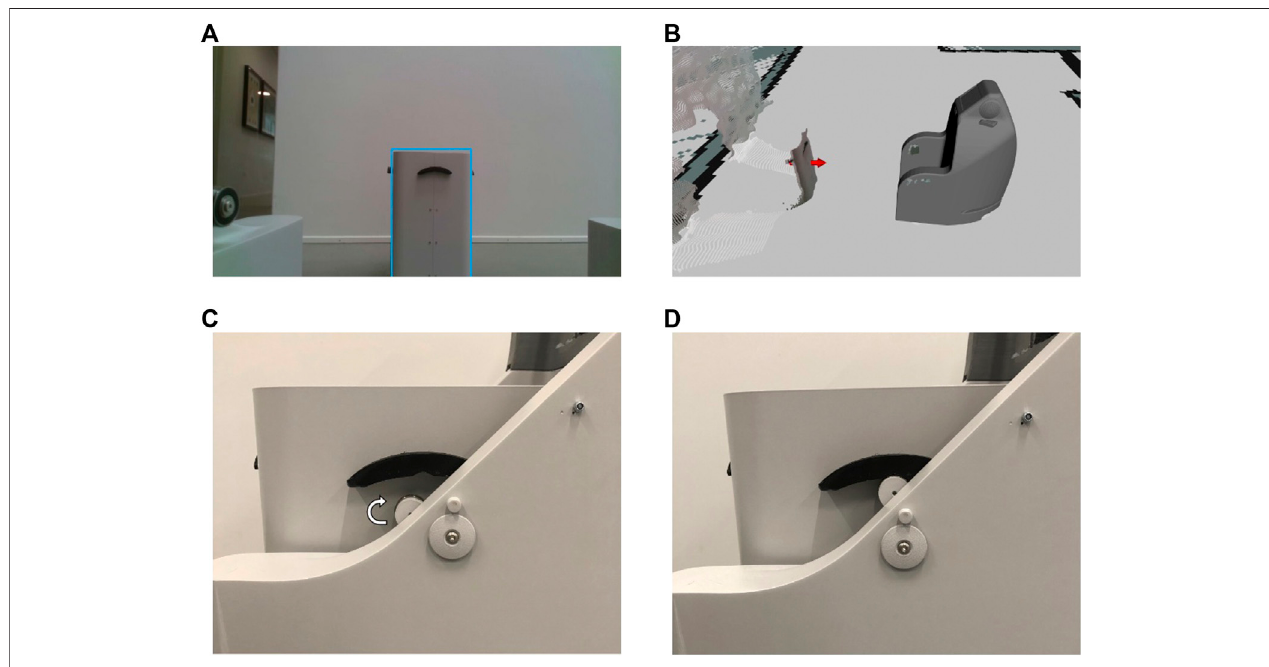
FIGURE 14 | (A) Bin detection (blue rectangle) and (B) pose estimation (red arrow) during the docking behavior. (C,D) Lifting mechanism on